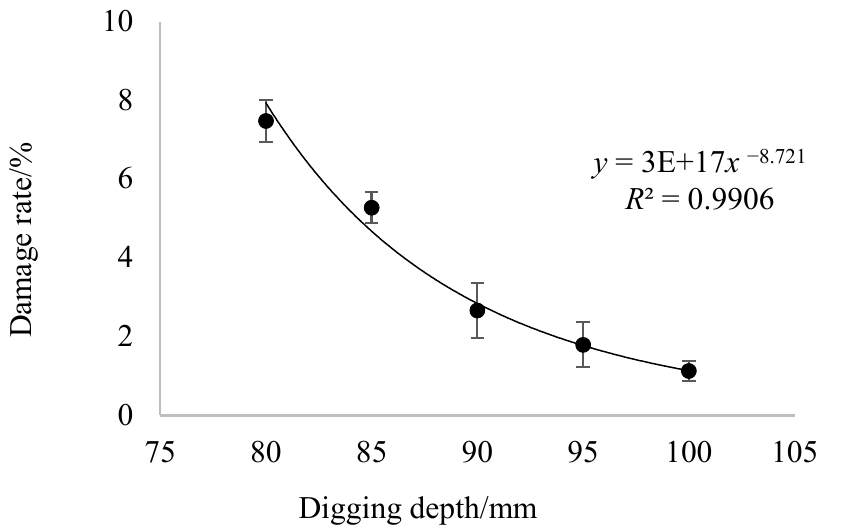
Figure 9. Effect of equivalent friction on damage rate on digging depth. Note: working speed was 1.48 km · h − 1 , lifting speed was 0.81 m · s − 1 and cutting height was 70 mm.